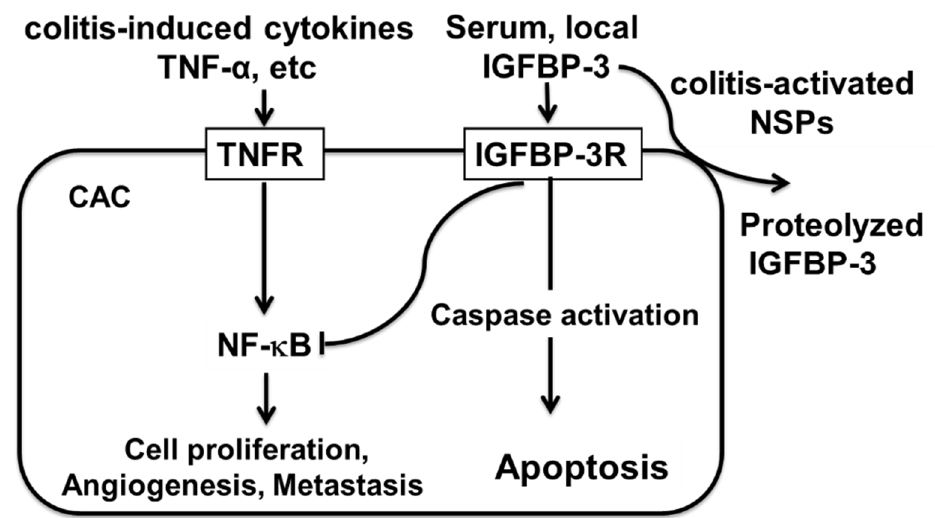
Figure 6. Central hypothesis: Colonic inflammation-induced NSPs proteolyze IGFBP-3 in circulation, thereby inhibiting endocrine/paracrine/autocrine-derived antitumor and anti-inflammatory actions of IGFBP-3 in CAC. IGFBP-3 activates IGFBP-3R and induces caspase-dependent apoptosis as well as inhibiting colitis-induced NF- κ B-signaling, thereby resulting in suppression of CAC progression.